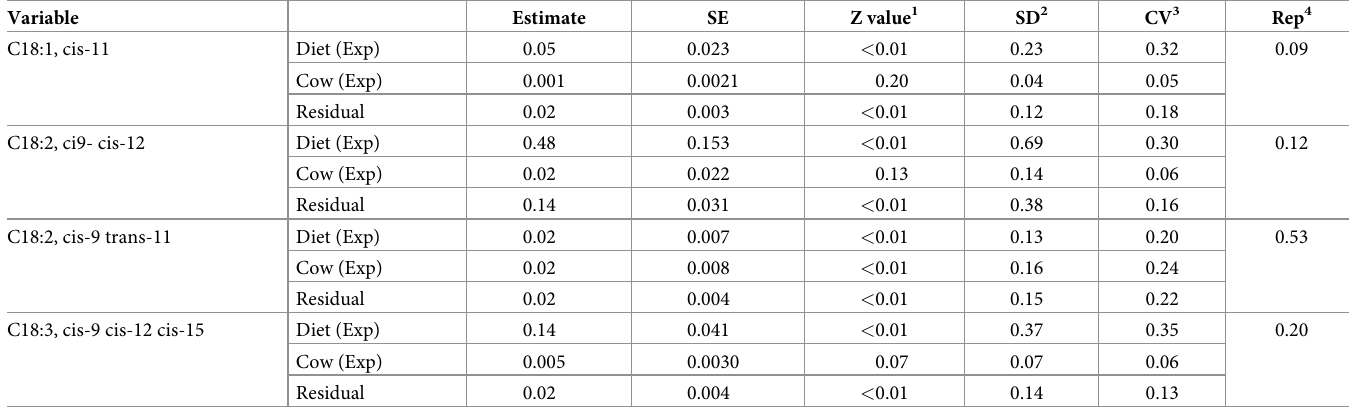
Calculated as the square root of the variance component estimate. 3 Calculated as SD divided by the respective mean value of the variable. 4 Rep = σ 2 Cow/( σ 2 Cow + σ 2